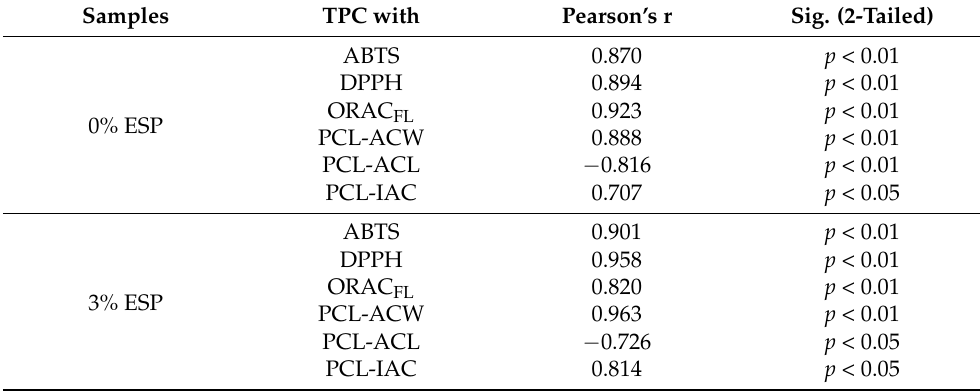
Table 5. Pearson’s correlation coefficient between total phenolics content and antioxidative activities of gingerbread